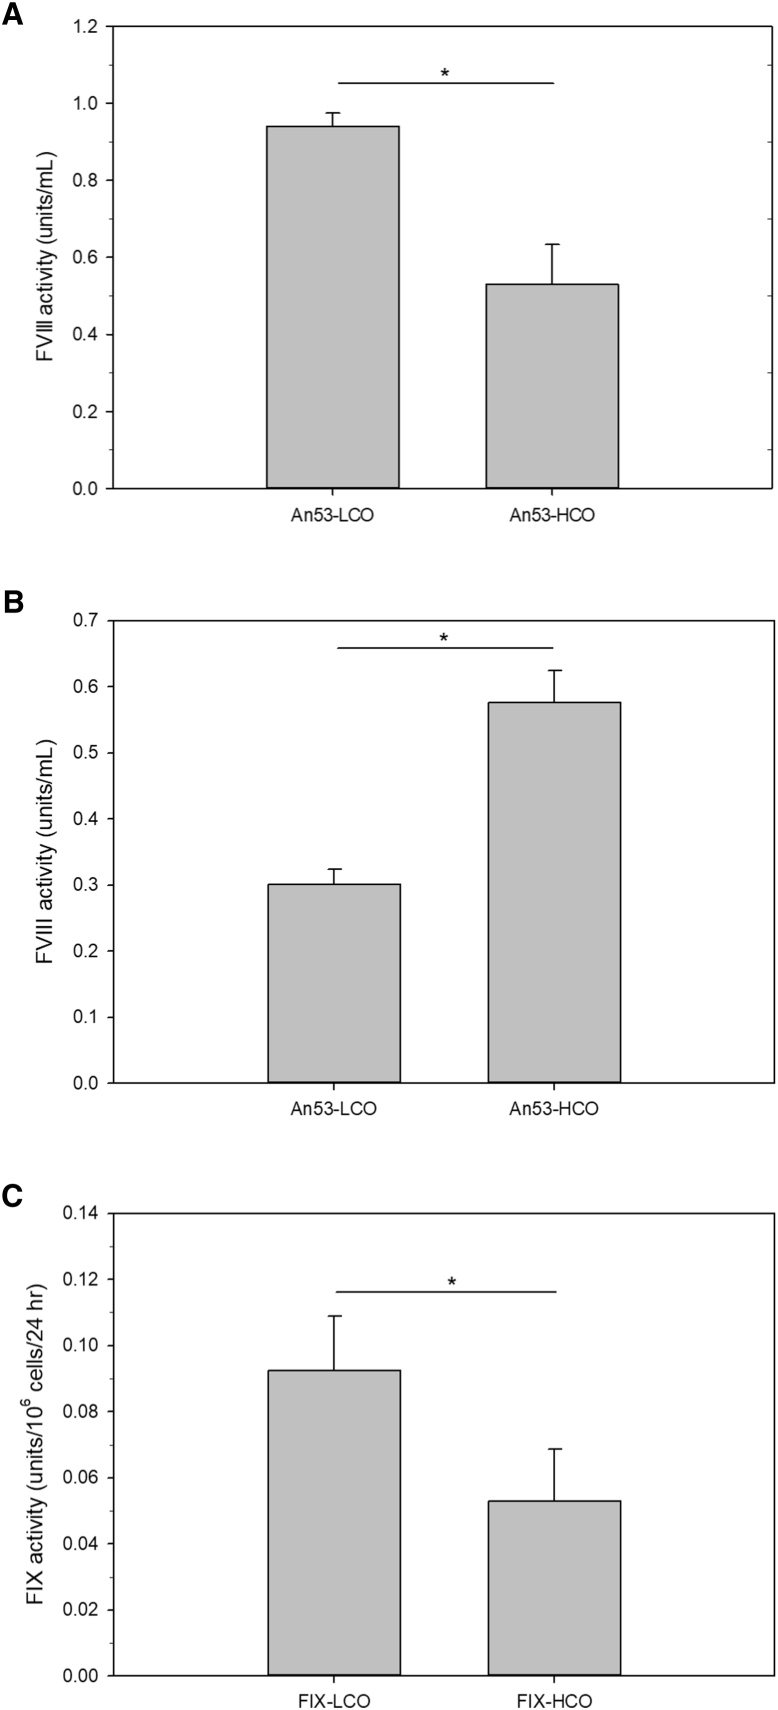
Expression and Tissue Specificity of HCO versus LCO(A and B) An53-HCO and An53-LCO were transfected into (A) HepG2 cells and (B) BHK cells. fVIII activity from conditioned media was measured 48 hr after transfection (*p < 0.05 by two-tailed t test). (C) fIX-LCO and fIX-HCO plasmids were transfected into HepG2 cells supplemented with vitamin K. fIX activity was measured 48 hr after transfection (*p < 0.05 by two-tailed t test). Data are presented as the mean ± sample SD.